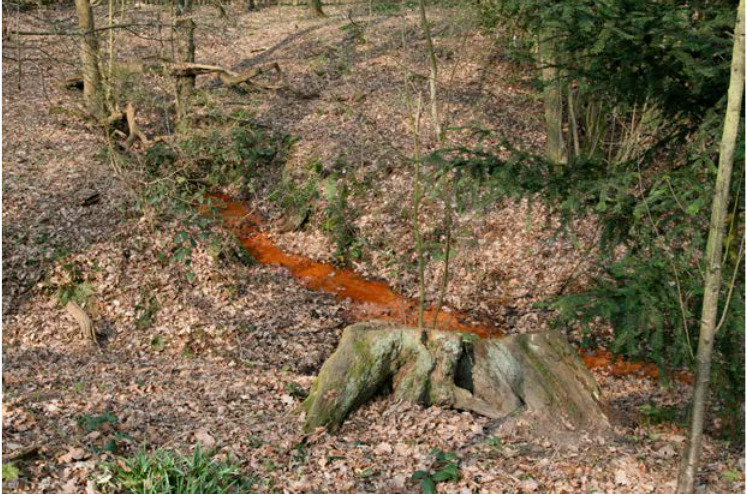
Figure 1. Natural acid rock drainage precipitating ferrihydrite in the head waters of the River Fleet, on Hampstead Heath, London. The occurrence of these ochres are extremely noticeable features on the landscape. Photo. R. Siddall.